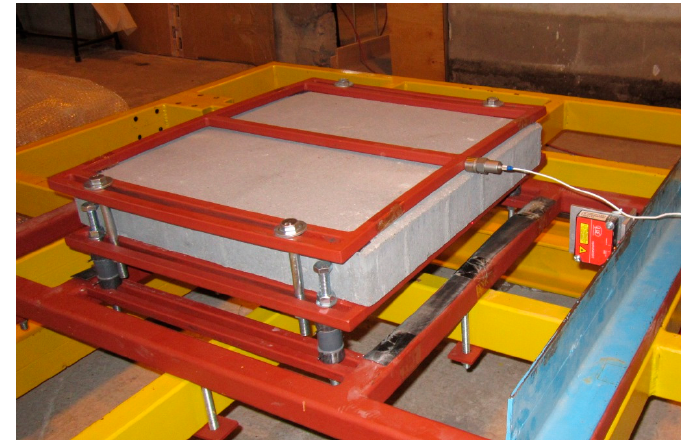
Figure 2. Base-isolated concrete slab during dynamic oscillatory test.